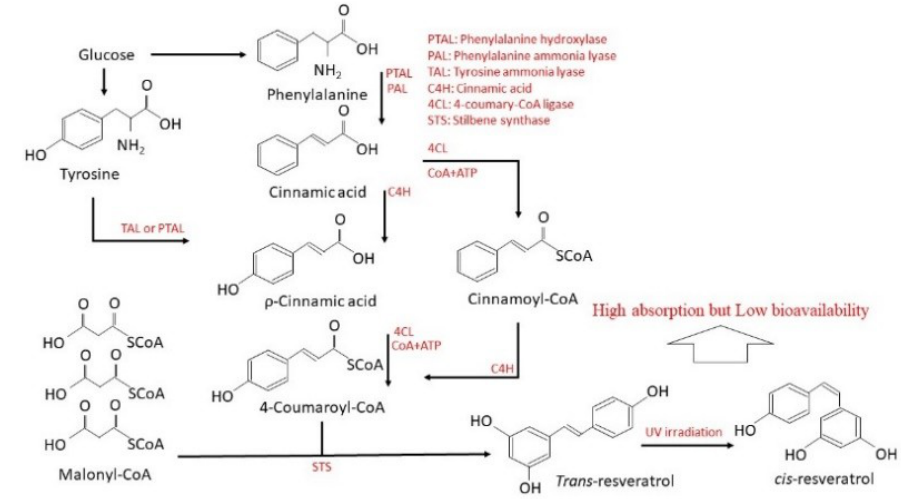
Figure 1. Pathway of resveratrol in plant.